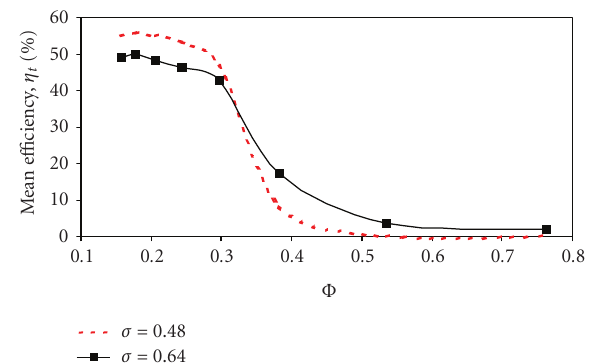
Figure 5: E ff ect of rotor solidity on the mean e ffi ciency of CA9 un- der sinusoidal flow conditions.